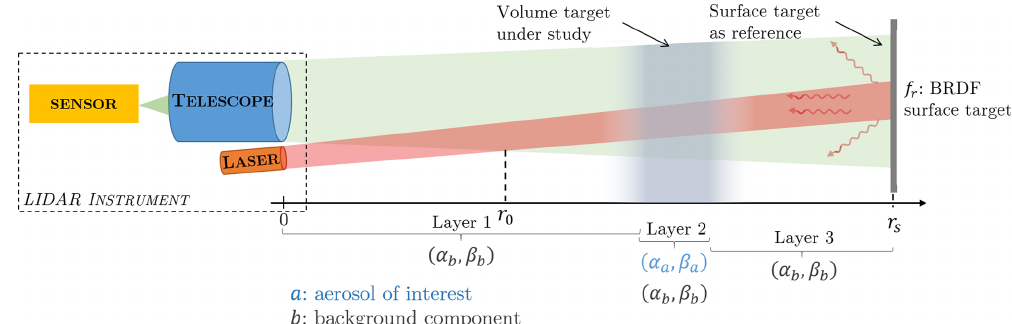
Figure 1. Illustration of the experimental